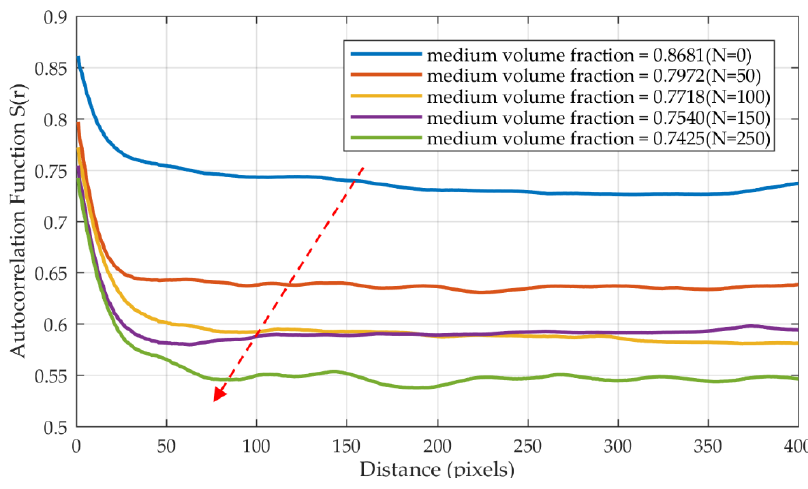
Figure 15. Autocorrelation functions under the accumulation of thermal shocks. Table 4. The particle size, hydraulic diameter and specific surface of original images and reconstructed models.